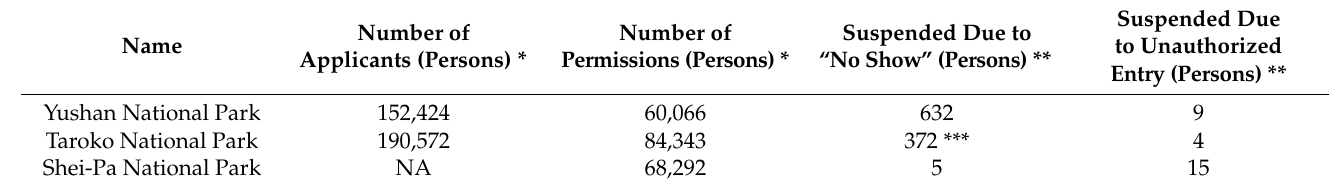
Table A1. The number of suspended visitors due to “no show” and unauthorized entry in three national parks in Taiwan in